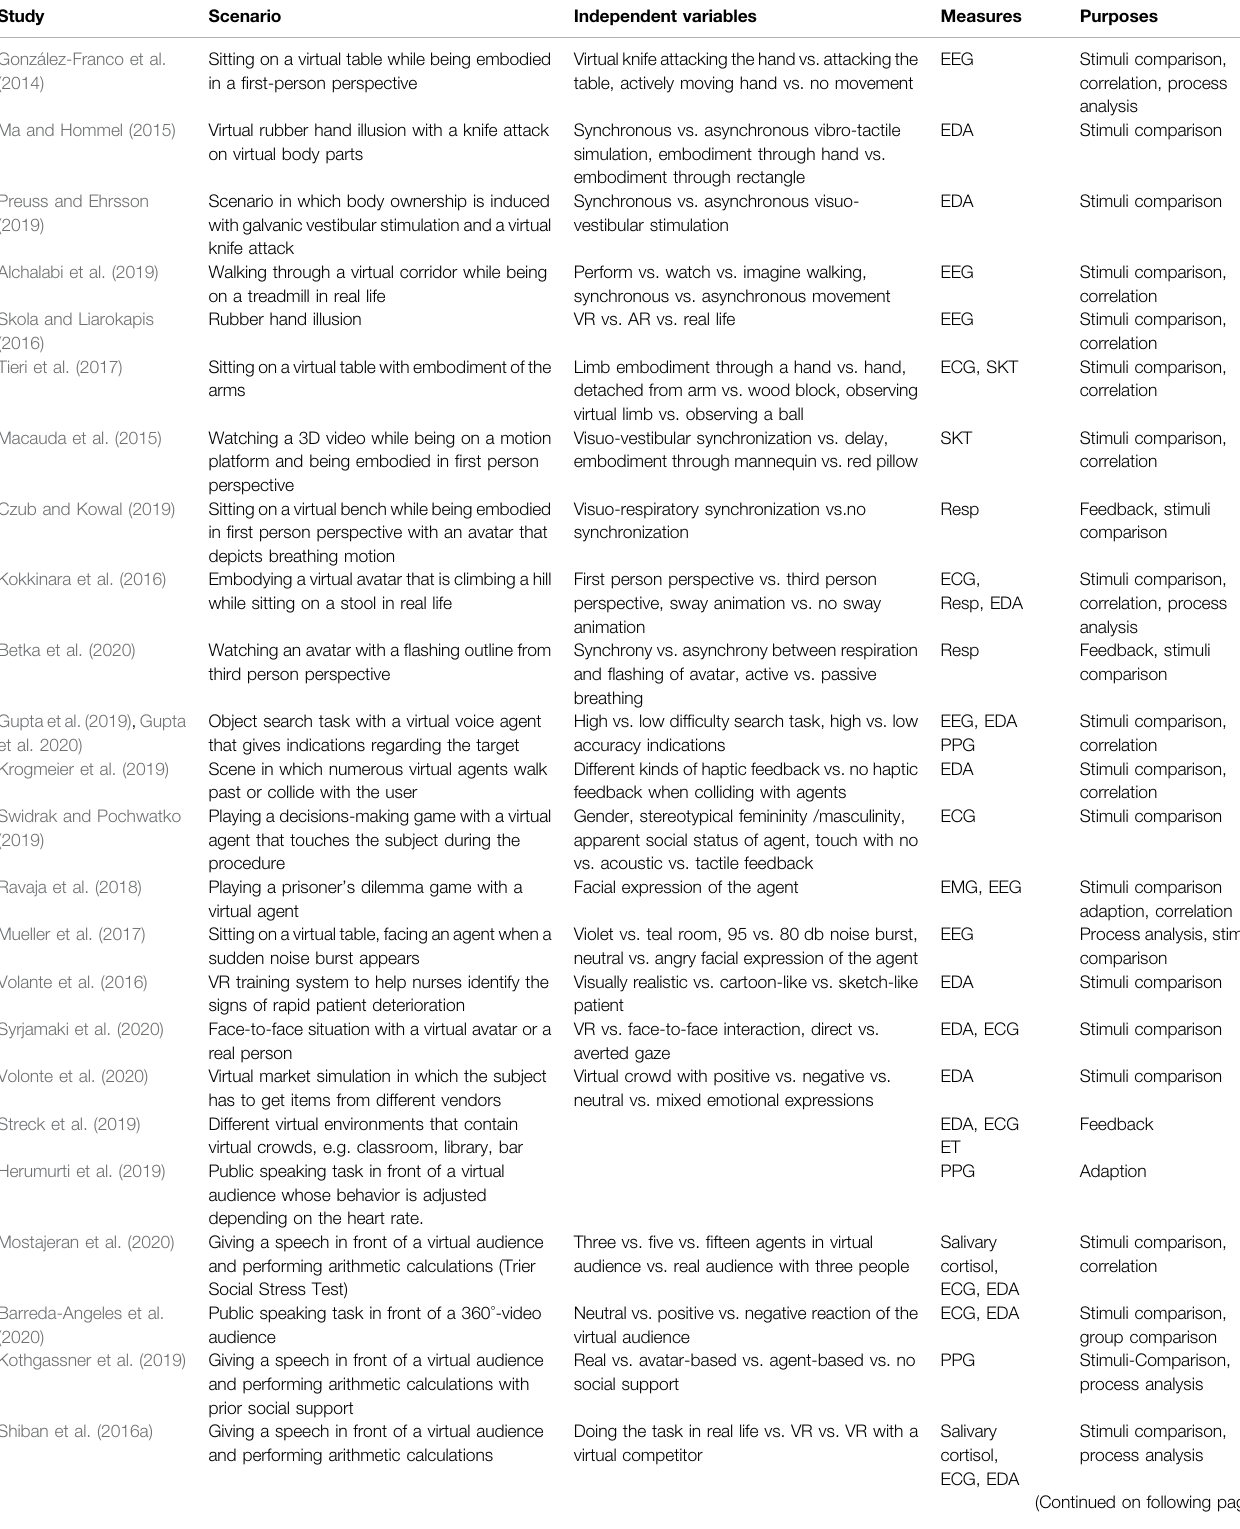
TABLE 8| Overviewoftheworksfromthe fi eldoffunctional VRproperties thatwerediscussed in Section 4.1.4 .TheMeasures columnrefers tothephysiological measures usedinthework.TheentriesoftheIndependentVariablescolumnoftendonotcovereverythingthatwasconsideredinthework.EntriesinthePurposescolumnreferto the categories listed in Section 4.1.6